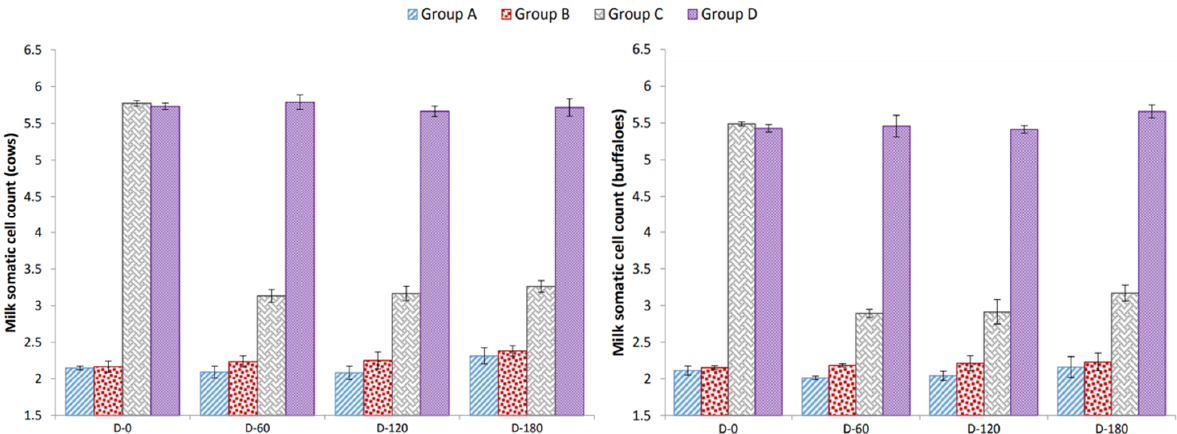
Figure 1. Effect of HS–mastitis combined vaccine on somatic cell count ( × 10 5 mL of milk); Group A = vaccinated cows (Milk culture − ve for S. aureus and Str. agalactiae , SFMT − ve); Group B = unvac- cinated cows (Milk culture − ve for S. aureus and Str. agalactiae , SFMT − ve); Group C = vaccinated cows (Milk culture + ve for S. aureus and Str. agalactiae , SFMT + ve); Group D = unvaccinated cows (Milk culture + ve for S. aureus and Str. agalactiae , SFMT + ve).